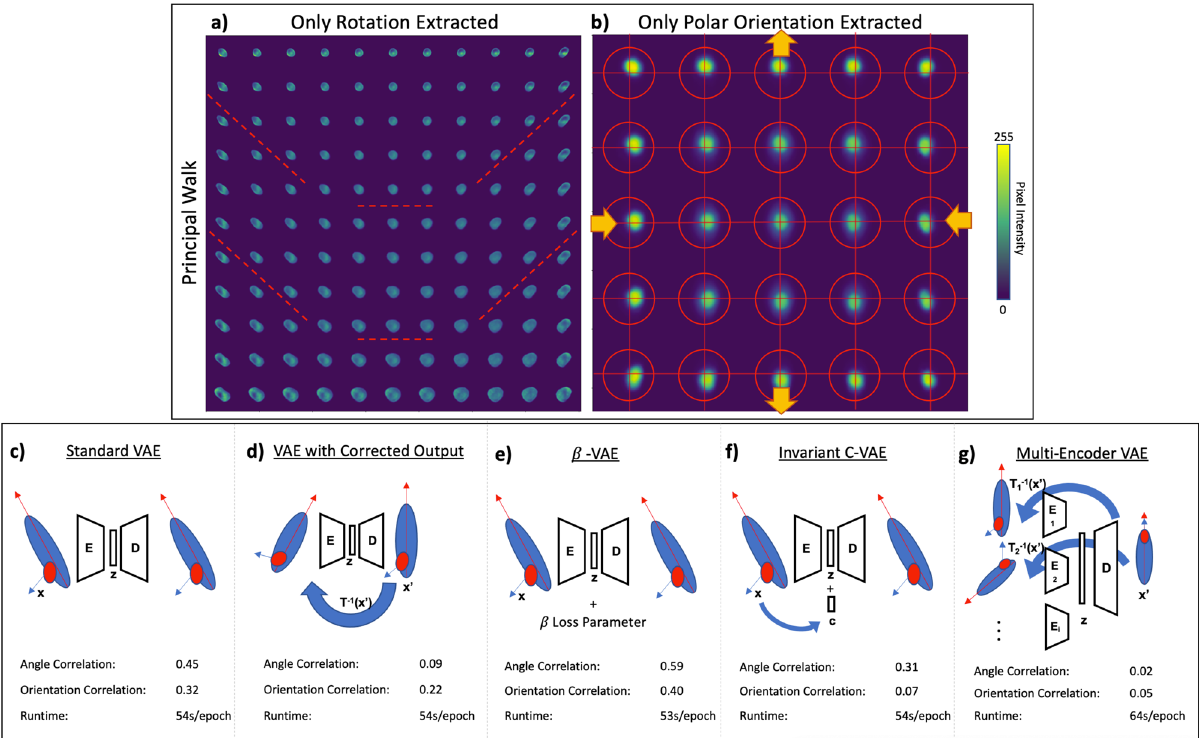
Fig. 1 VAE hypersensitivity and proposed model architecture. VAE analysis of two datasets is shown, each governed by a single biologically uninformative feature a rotation and b polar orientation. Principal walk reconstructions 23 show the VAEs ’ governing features across the latent space through a range of image reconstructions. To correct this model hypersensitivity, several architectures were tested: c standard VAE with matched raw images; d VAE with paired randomly transformed input and controlled output images; e β -VAE that operates similarly to the Standard VAE, but utilizes a β hyperparameter in the loss function to encourage an independent latent space; f an invariant conditional VAE that injects the values of the uninformative features into the decoder such that they are not embedded in the latent space; g the proposed multi-encoder VAE: VAE with corrections for multiple features (rotation, polar orientation, size, shape, etc.) using parallel encoder models, a shared latent space, and a single decoder model. In c – e , a correlation between the embedding components and the respective feature (angle and orientation) is measured to quantify how effectively the model removes uninformative features. PBS and TGF β + EGF cell populations with single channels were used in this analysis ( n = 15,898 single-cell